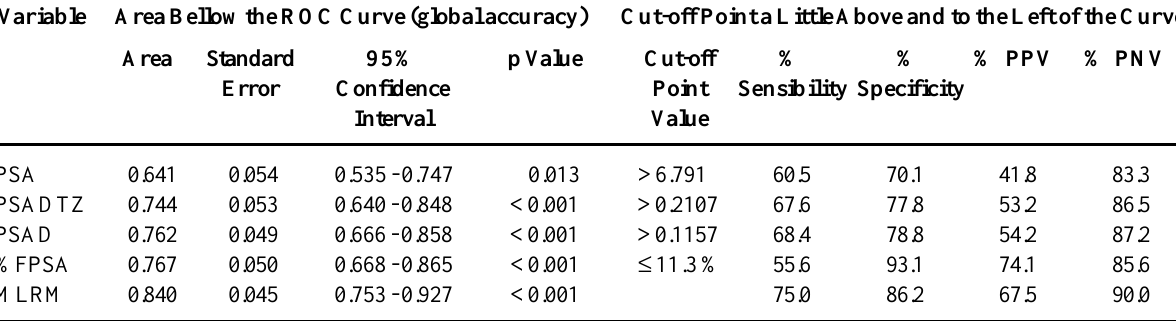
Table 6 – Area bellow the ROC curve (global accuracy) and sensibility, specificity, predictive positive value(PPV) and negative predictive value (NPV) for the cut-off points that have produced the best sensibility and specificity rates (cut-off point a little above and to the left of the